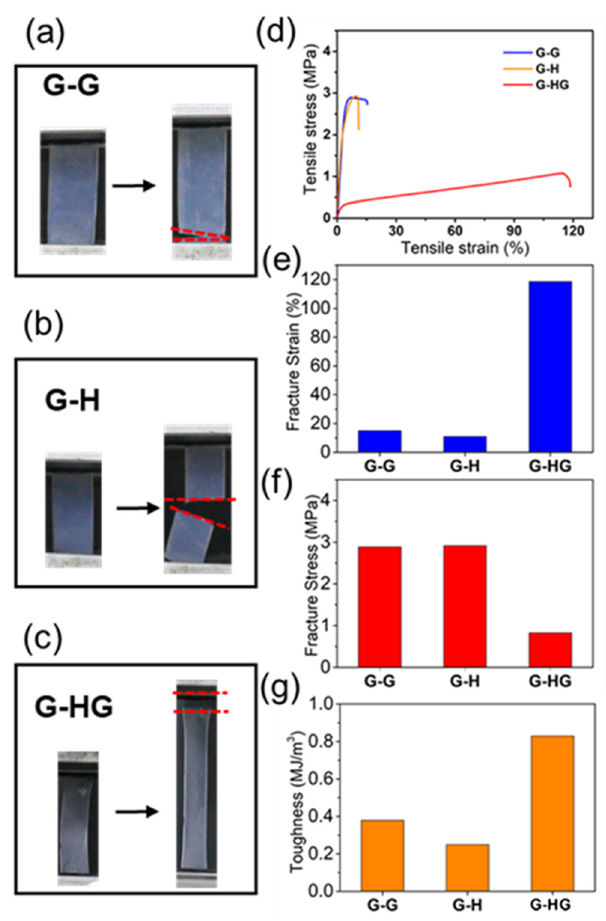
Figure 3. Photographs of the polymer gels of ( a ) G-G , ( b ) G-H , and ( c ) G-HG during the tensile tests. ( d ) Stress–strain curves, ( e ) fracture strain, ( f ) fracture stress, and ( g ) toughness of the G-G , G-H , and G-HG polymer gels.